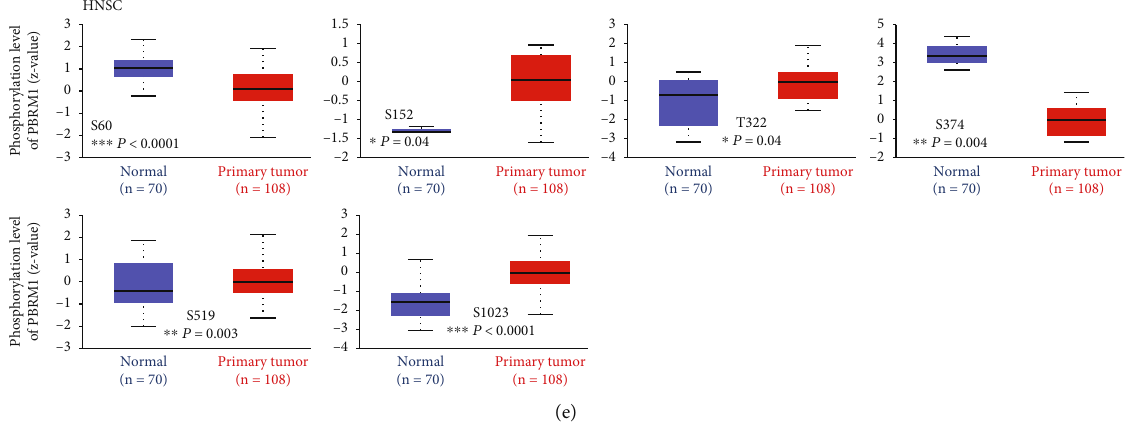
Figure 4: Tumor-related protein phosphorylation in PBRM1. Comparison of the level of PBRM1 proteins (Y372, S374, S60, S519, S526, T525, S152, T322, and S1023) among normal systems and basic systems of chosen tumors. (a) Block diagram representation of PBRM1 protein levels in breast cancer. (b) Block diagram representation of PBRM1 protein levels in clear cell RCC. (c) Block diagram representation of PBRM1 protein levels in LUAD. (d) Block diagram representation of PBRM1 phosphoprotein levels in LICH. (e) Block diagram representation of PBRM1 protein levels in